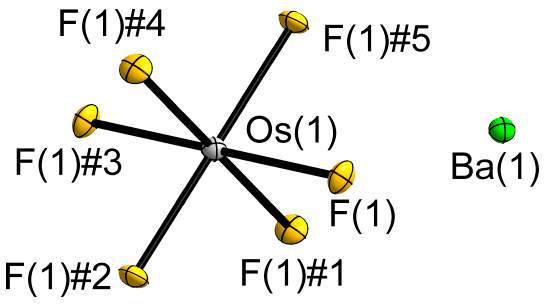
Figure 8. Formula unit of BaOsF 6 . Displacement ellipsoids are shown at 70% probability at 100 K.